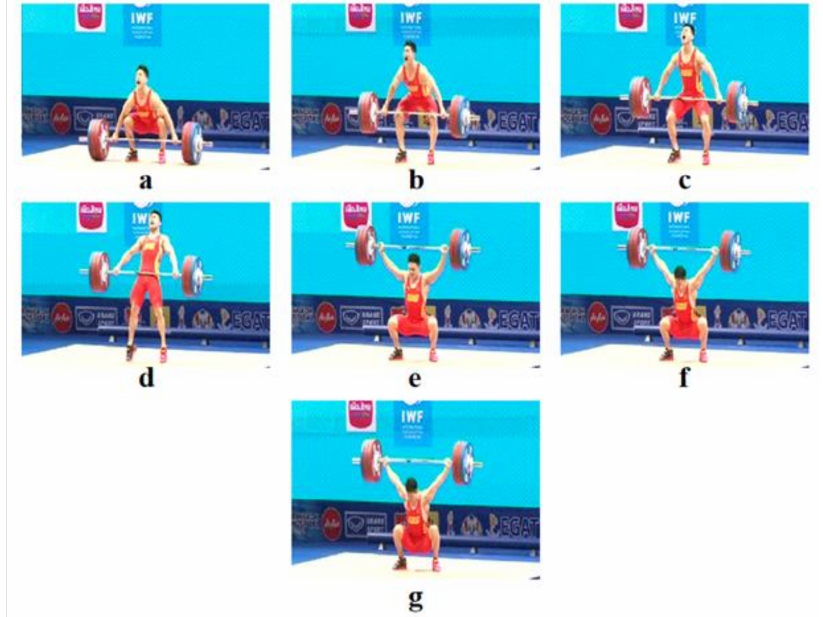
Figure 3. Analysis definition of the phase division in snatch (M1 ( a , b ) is from start position to the instant of first maximal knee extension angle; M2 ( b , c ) is the instant of the knee angle from maximum to minimum; M3 ( c , d ) is from the end of M2 to the maximal vertical rising velocity of barbell; M4 ( d , e ) is from the end of M3 to the maximal vertical height of the barbell; M5 ( e , f ) is from the end of M4 to the maximal vertical falling velocity of the barbell. M6 ( f , g ) is from the end of M5 to squat